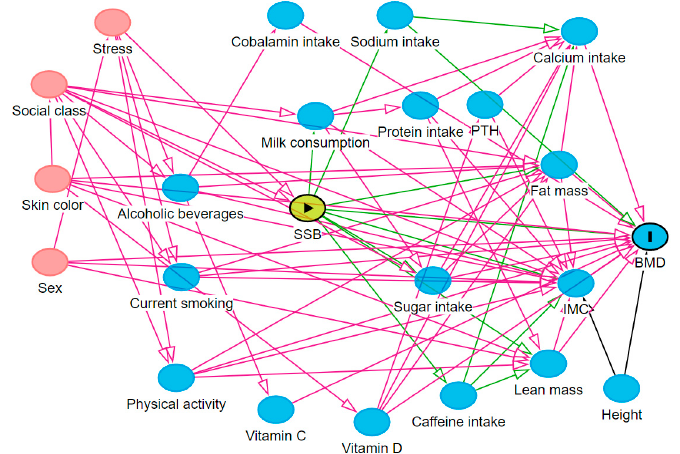
Figure 1. Directed acyclic graph of the association between the consumption of sugar-sweetened beverages (exposure) and bone mineral density (outcome).